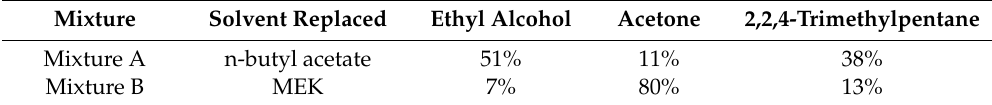
Table 2. Composition (% concentration) of the two solvent mixtures tested (Mixtures A and B).